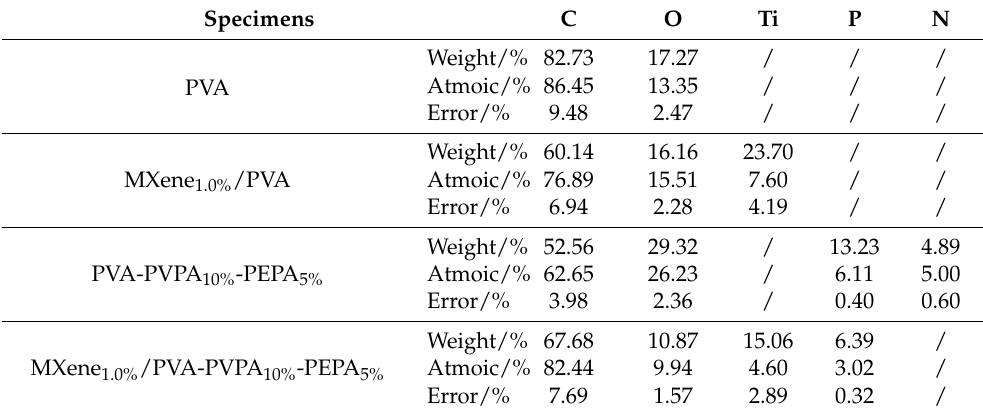
Table 4. Element composition of the char residue of PVA and MXene/PVA nanocomposites after cone calorimeter